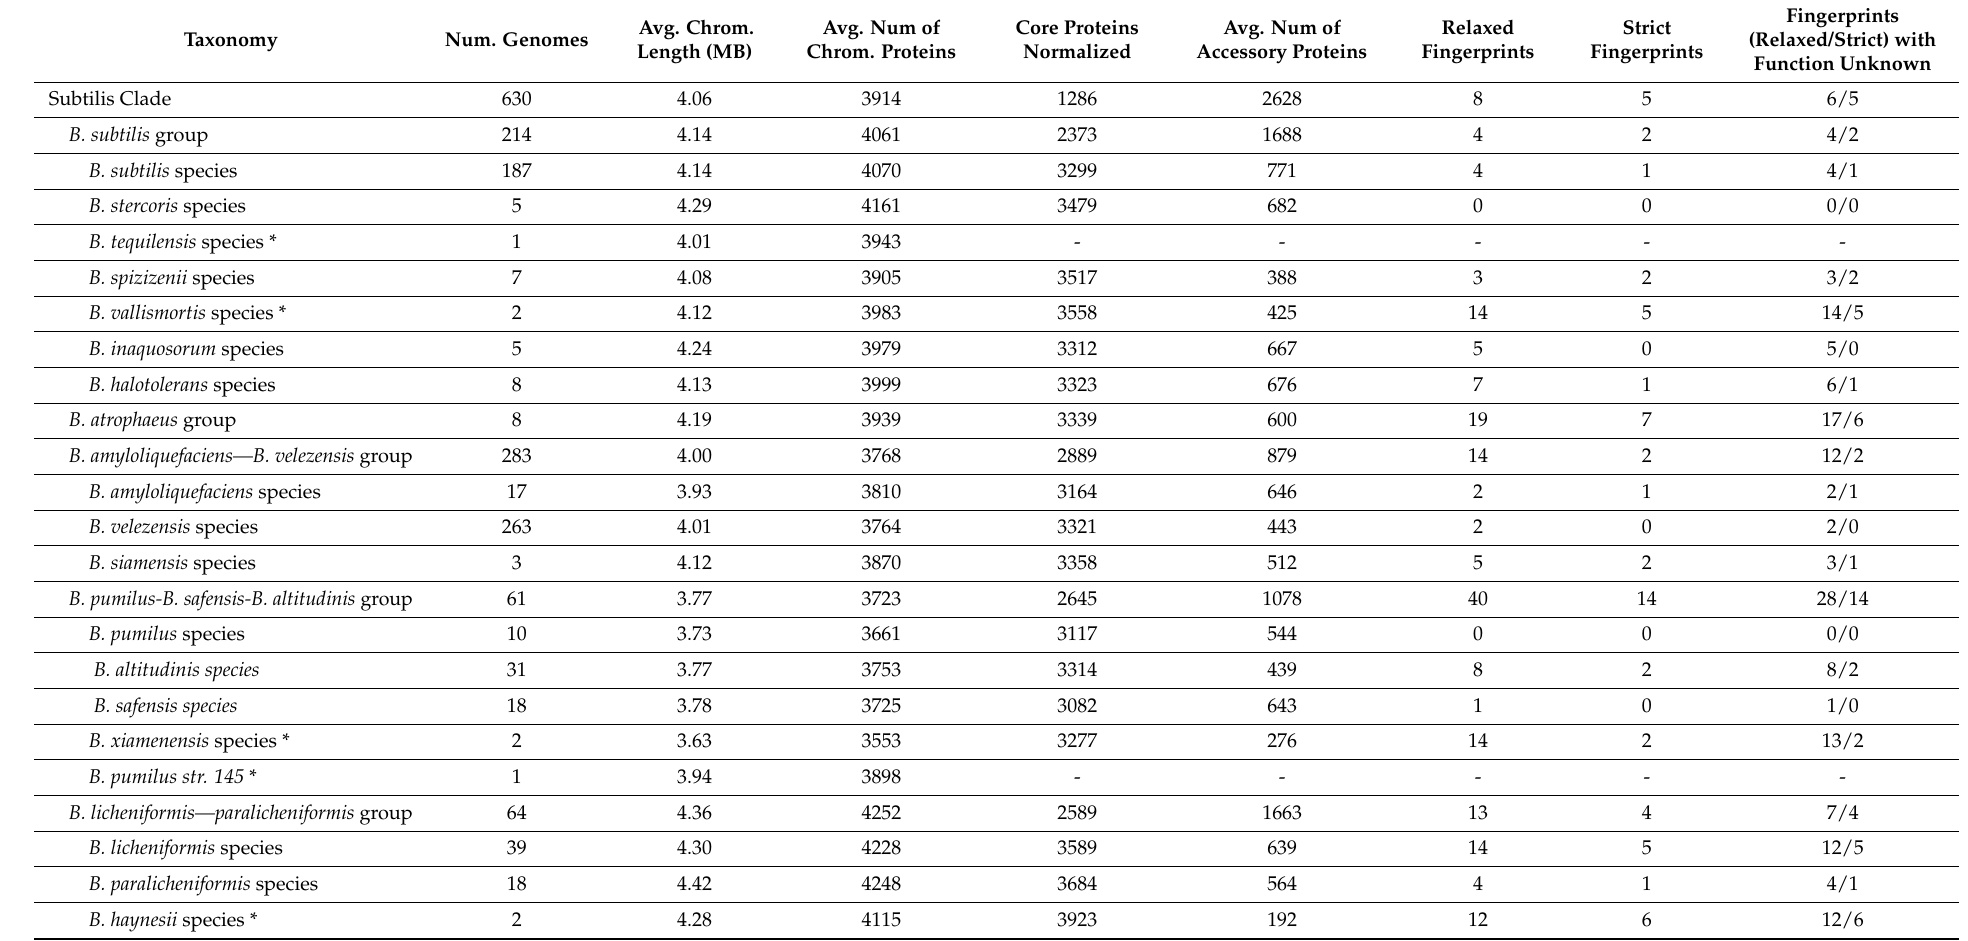
Table 1. The genomic characteristics of the evolutionary lineages and species of the Subtilis and Cereus Clades. The number of core proteins and fingerprints for each clade/group/species are based on the normalized dataset. As normalized, we denote a dataset where the maximum number of genomes used per species is five (or less, if not available). Thus, sampling biases for certain lineages with very high numbers of available genomes are mitigated and the results between different lineages become comparable. The stars indicate species with only one or two available complete